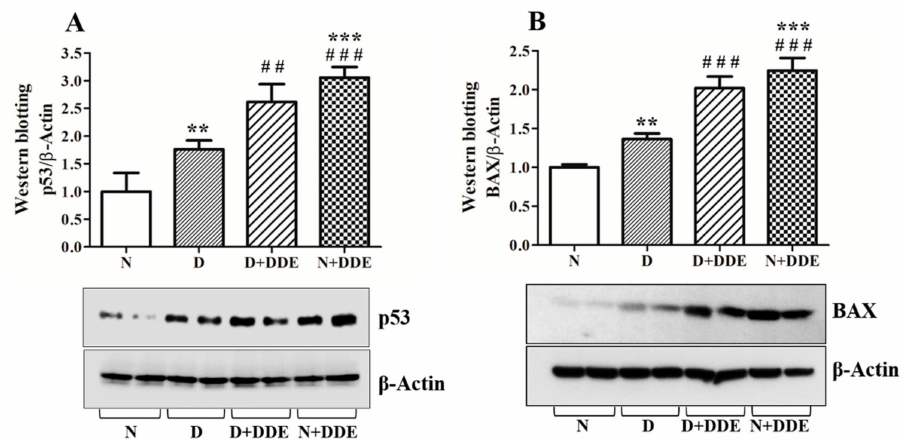
Figure 3. Analysis of p53 ( A ) and BAX ( B ) protein levels in the total homogenate. The data, obtained as mean ± standard deviation, were showed as folds of change vs. N and graphically represented. One-way ANOVA analysis showed significant di ff erences between treated and control rats: ** p < 0.01 vs. N; *** p < 0.001 vs. N; # # p < 0.01 vs. D; # # # p < 0.001 vs. D. Two-way ANOVA analysis